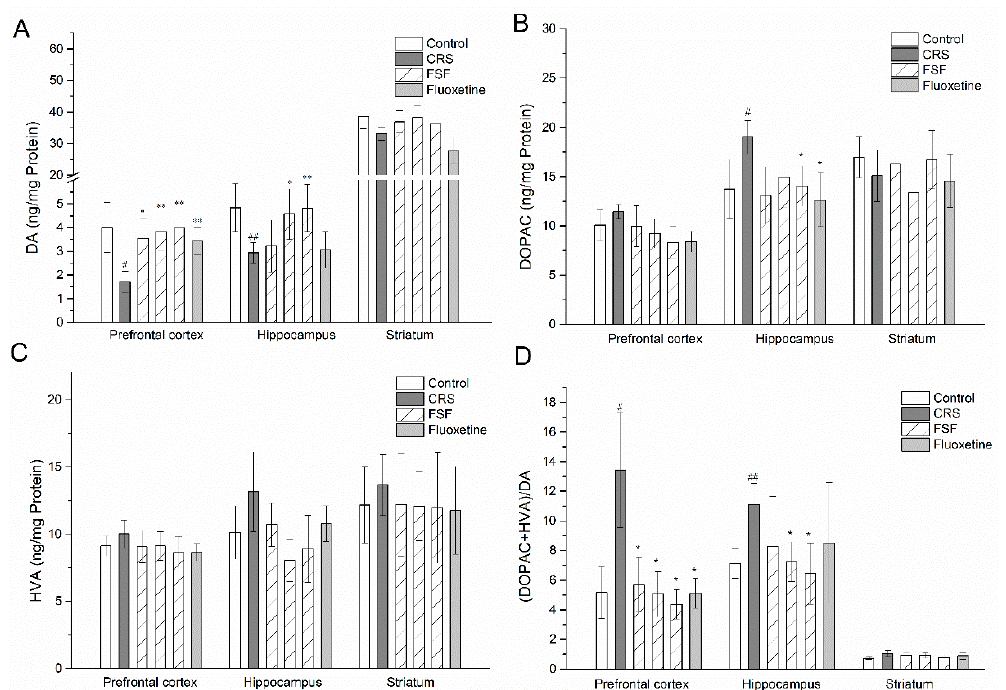
Figure 8. Effects of FSF on DA and its metabolites levels in the prefrontal cortex, hippocampus and striatum in mice. ( A ) The level of DA. ( B ) The level of DOPAC. ( C ) The level of HVA. ( D ) The rate of (DOPAC+HVA)/DA. n = 6, # p < 0.05, ## p < 0.01, vs. Control group; * p < 0.05, ** p < 0.01, vs. CRS group.